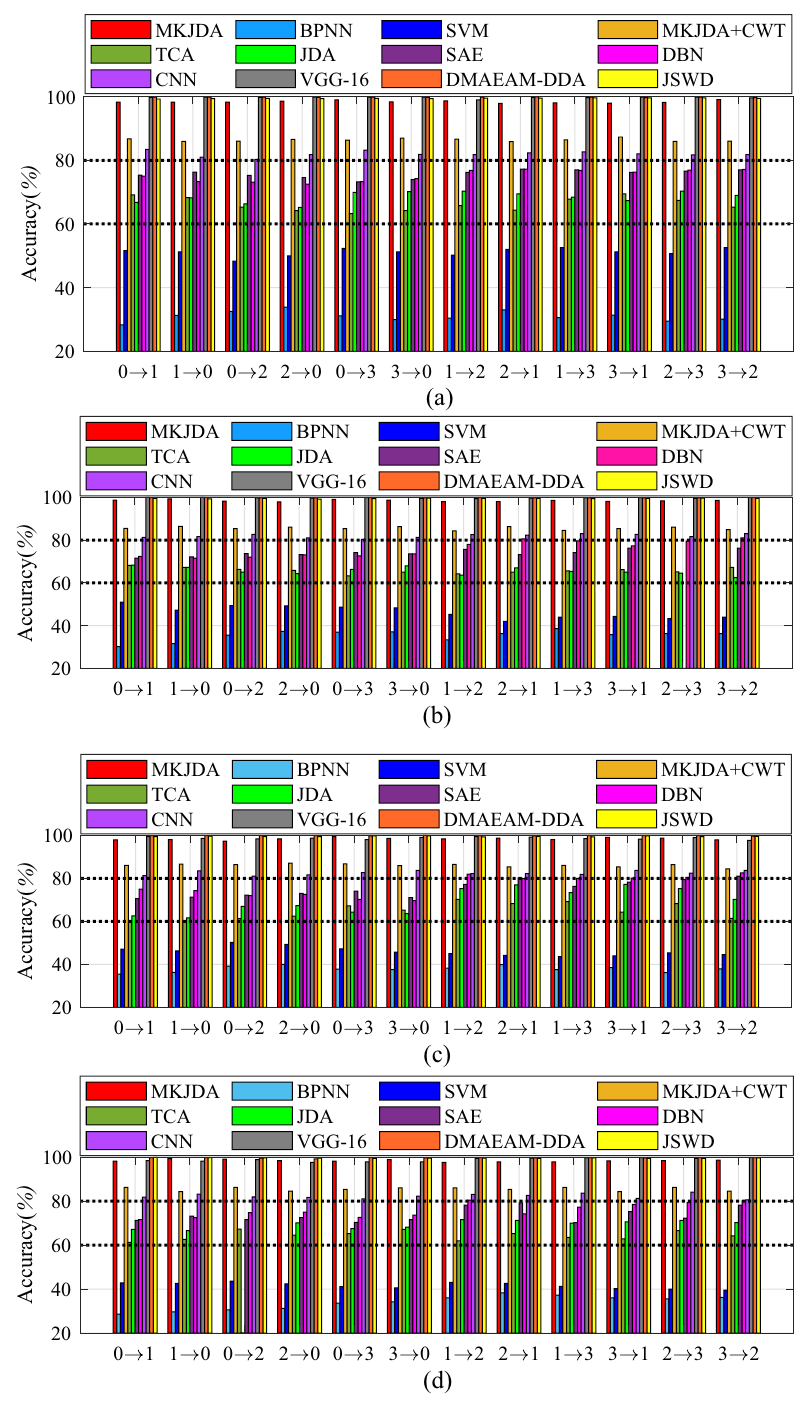
Figure 7. The comparative experimental results (task III). ( a ) Specificity (%); ( b ) precision (%); ( c ) recall (%) and ( d ) F